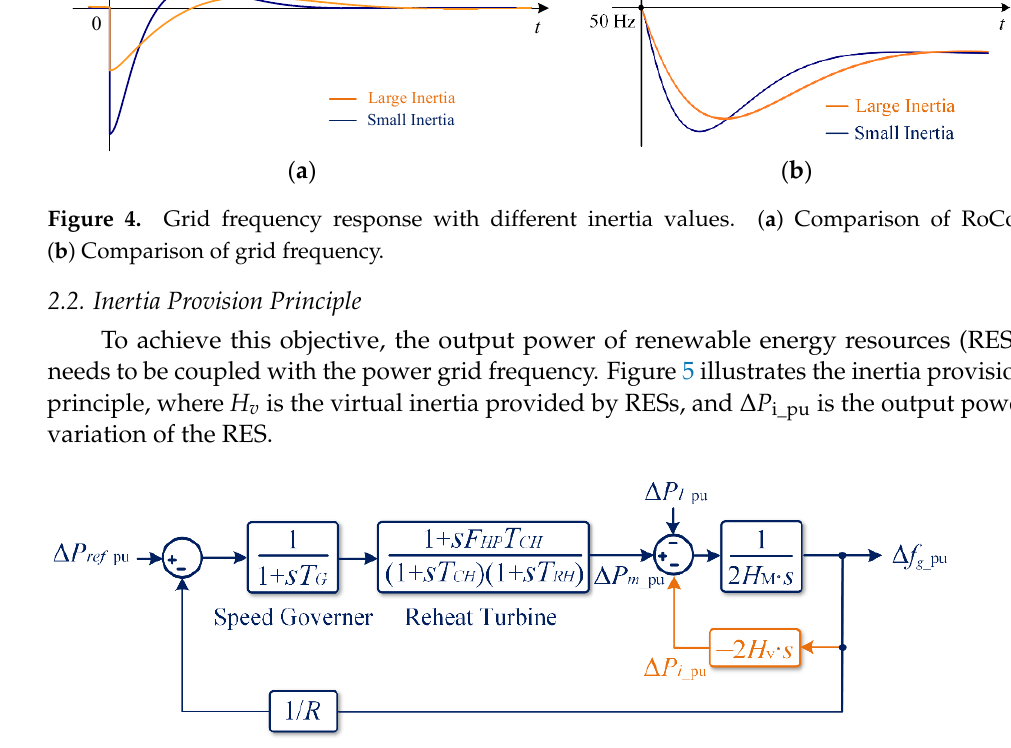
Figure 5. General control block diagram for inertia provision from RES systems.